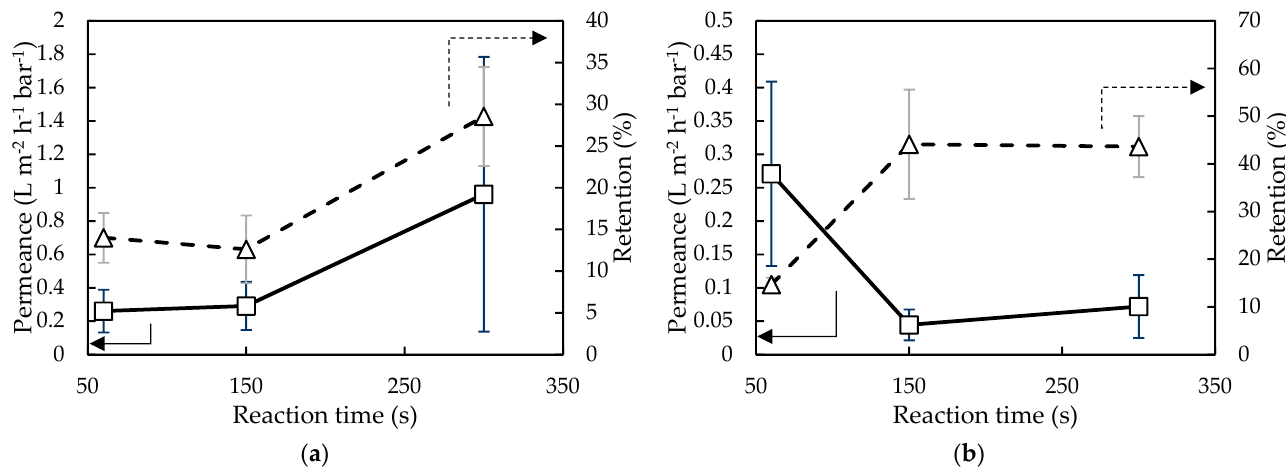
Figure 6. Milli-Q water/EtOH permeance and EA retention of membranes synthesized with ( a ) 1.5 wt% and ( b ) 21.3 wt% H 2 O in Aliquat and with varying reaction times (i.e., 60, 150, and 300 s). Additionally, the performances of these membranes were grouped per reaction time and compared to the performance of the commercial GEA RO membrane (type AF) (Fig- ure 7).